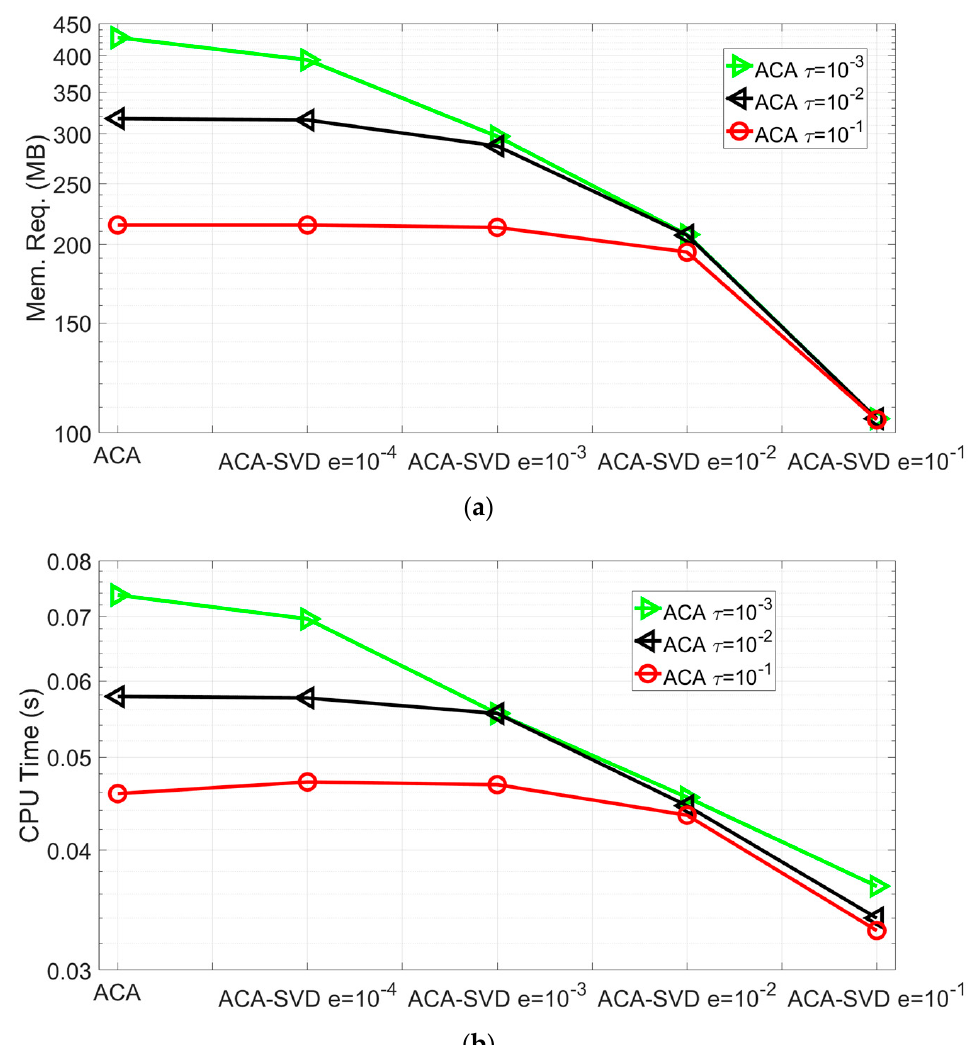
Figure 4. Performance of ACA-SVD based BEM forward solver for predicting the impedance varia- tions of placing coil C5 above conducting plate B1 with ACA tolerance τ = 10 − 1 ,10 − 2 ,10 − 3 and SVD truncated error e = 10 − 1 ,10 − 2 ,10 − 3 ,10 − 4 . ( a ) The memory requirements of the far block interactions. ( b ) CPU time per iteration.